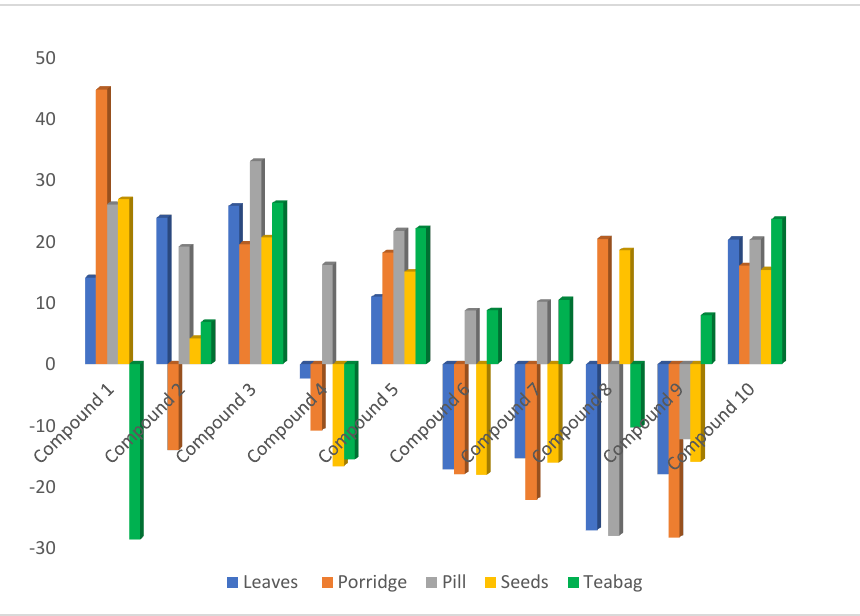
Figure 3. Representation of the percentage matrix effect experienced by the compounds in the different matrices.